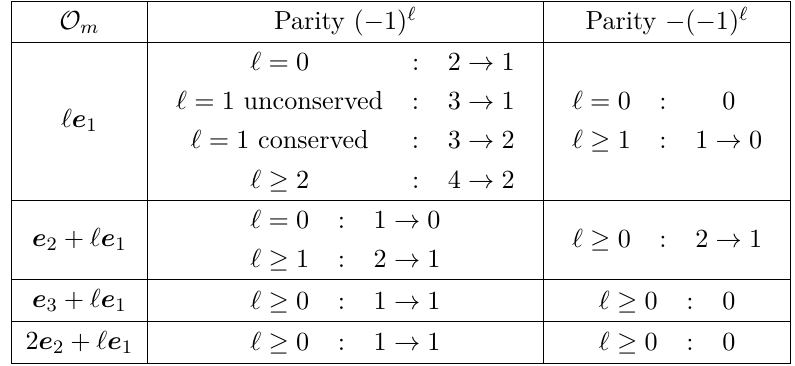
Table 1 . Number of independent tensor structures in three-point correlation